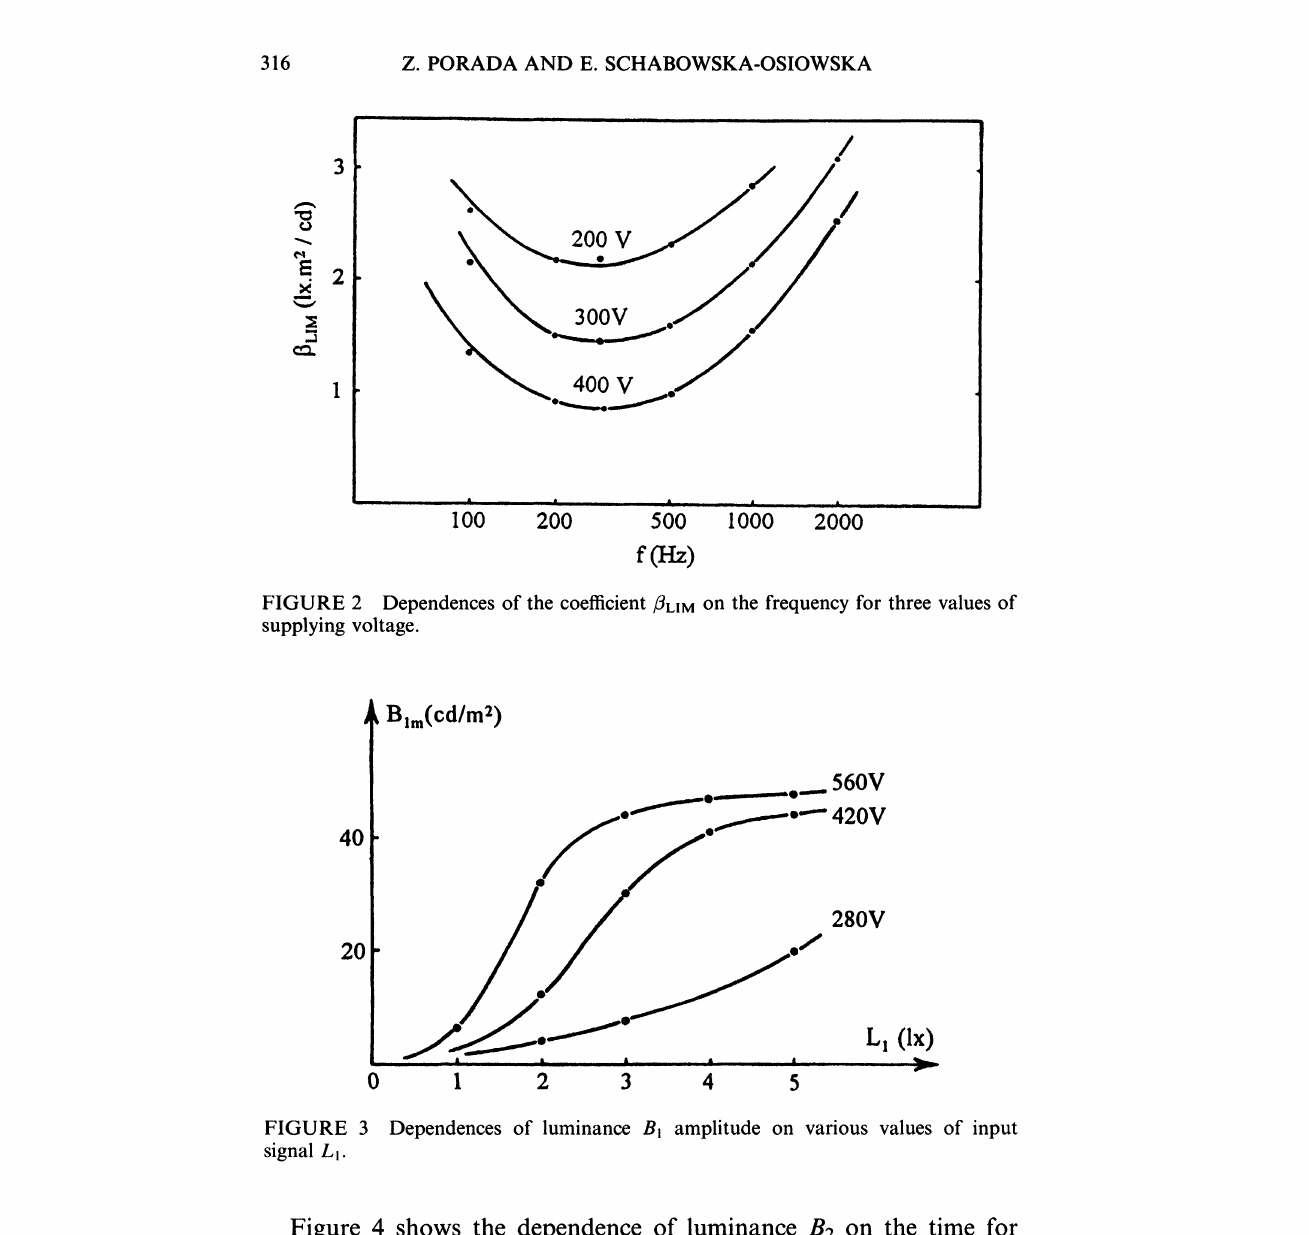
FIGURE 3 Dependences of luminance B amplitude on various values of input signal